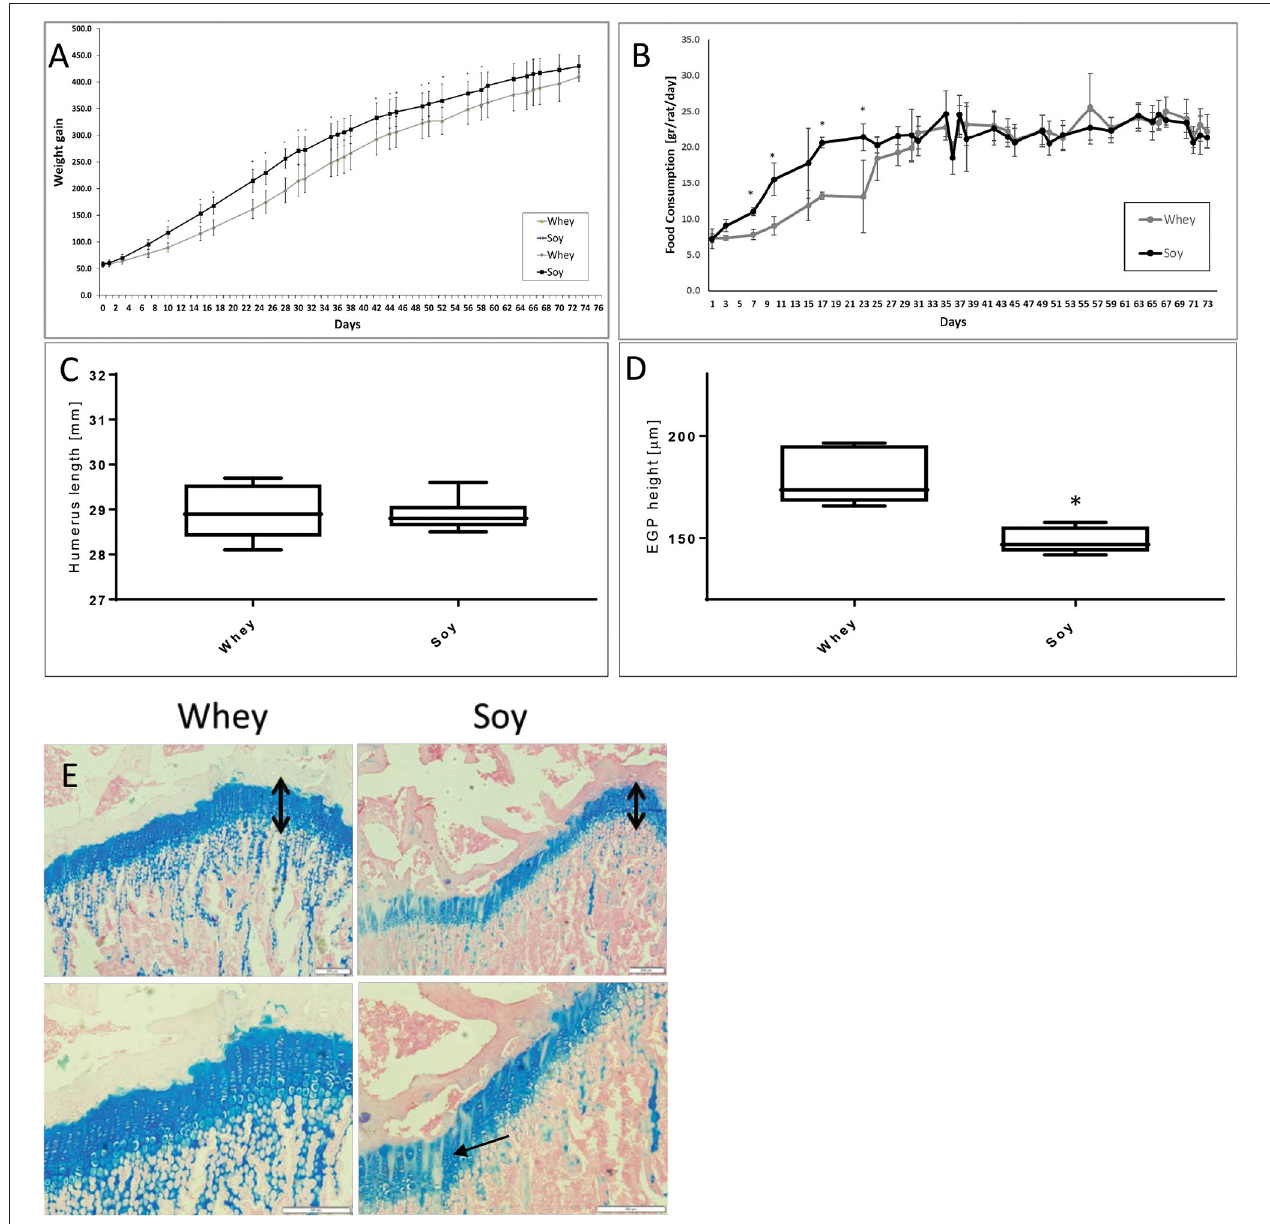
FIGURE 4 | Long-term experiment. (A) Animal body weight, (B) food consumption, (C) humerus length, (D) EGP height, (E) Representative stained sections of the epiphyseal growth plate (EGP) (upper panel magnification × 10; lower panel magnification X 20) (upper row magnification × 10, lower row magnification × 20). The black arrows indicate the height of the growth plates. Note the better organization of the EGP in the whey group (marked with arrows). Statistical analysis was done by Student’s T -test. The asterisk (*) within the graphs designates significant differences at p < 0.05 for Soy vs. Whey. (C,D) The box plot shows the minimum, first quartile, median, third quartile, and maximum in humerus length (C) and EGP height (D) after 74 days free feeding. EGP, epiphyseal growth